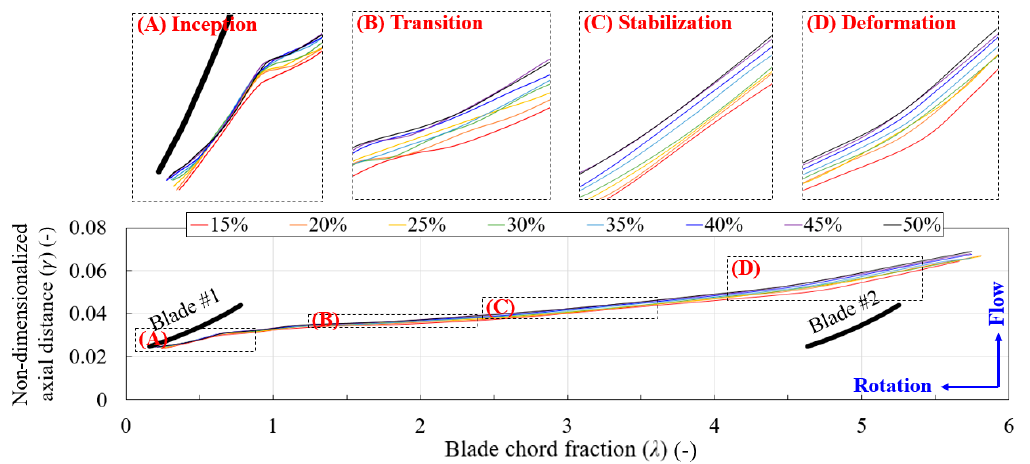
Figure 15. Trajectory of the tip leakage flow with different maximum thickness positions ( Φ / Φ des = 1.0).